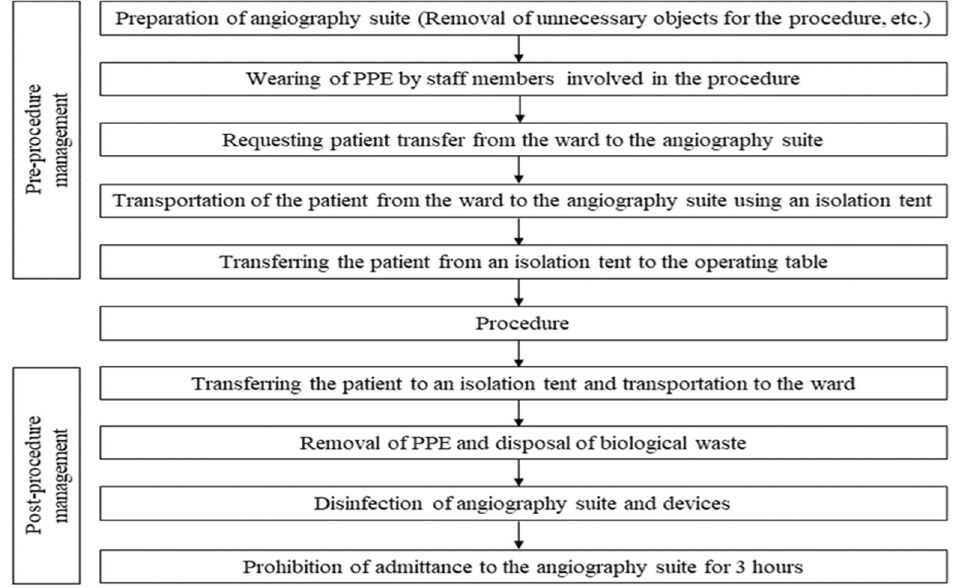
Figure 2. The process and sequence of interventional radiologic procedures in patients with COVID-19.